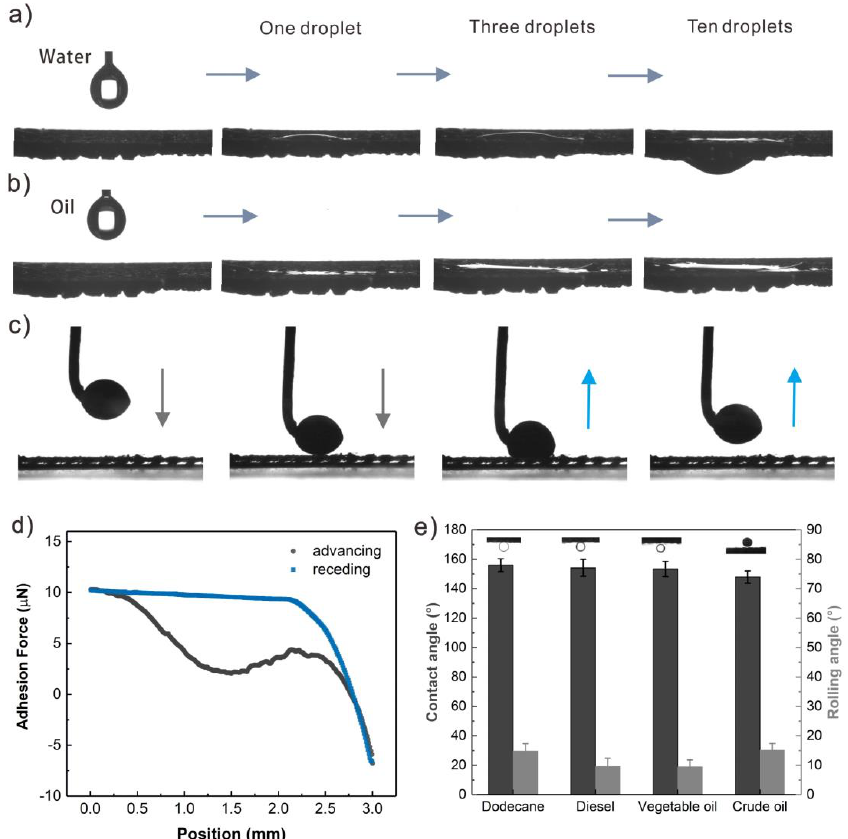
Figure 3. Wettability of S-USM. ( a ) Water contact angle of S-USM, where water droplets spread and permeate through the S-USM, whereas ( b ) oil droplets only spread on the mesh. ( c , d ) Crude oil droplets are repulsed over the S-USM underwater with a low adhesion force. ( e ) The underwater contact angle and sliding angle of four kinds of oil (dodecane, diesel, vegetable oil, and crude